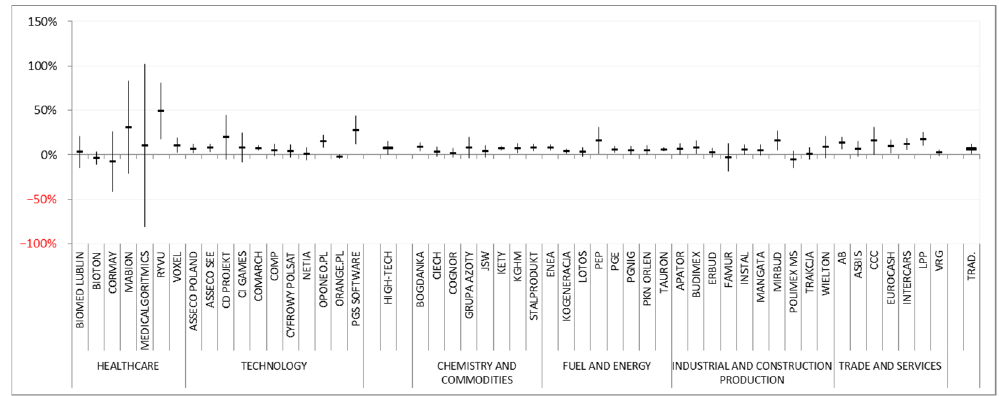
Figure 11. Typical area of total asset variation in the surveyed enterprises. Source: own work.